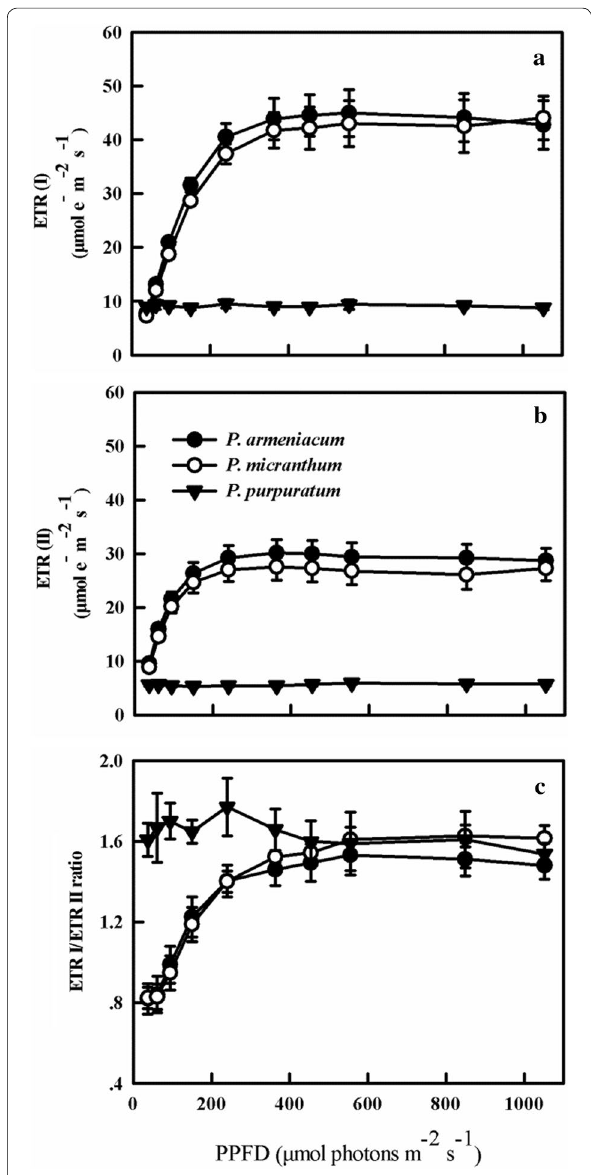
Fig. 9 Light‑response changes in photosynthetic electron flow through PSI (ETRI) ( a ) and PSII (ETRII) ( b ), and ETRI/ETRII ratios ( c ) in leaves from three species of Paphiopedilum at 25 °C. Mean calculated from 6 independent plants per species